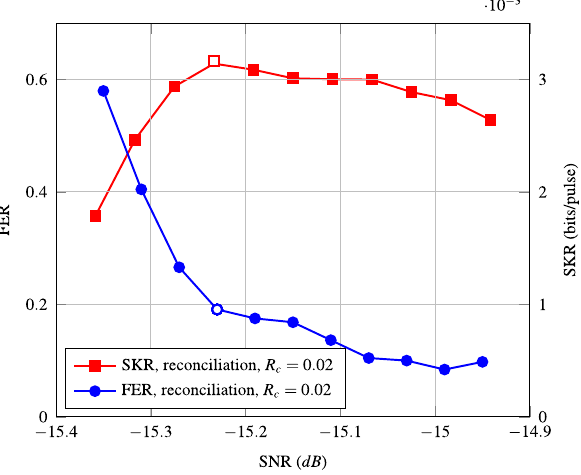
Figure 1. FER and SKR of the conventional protocol over a range of different SNRs for an LDPC code with R c = 0.02 . The points corresponding to the optimal SKR are shown with white